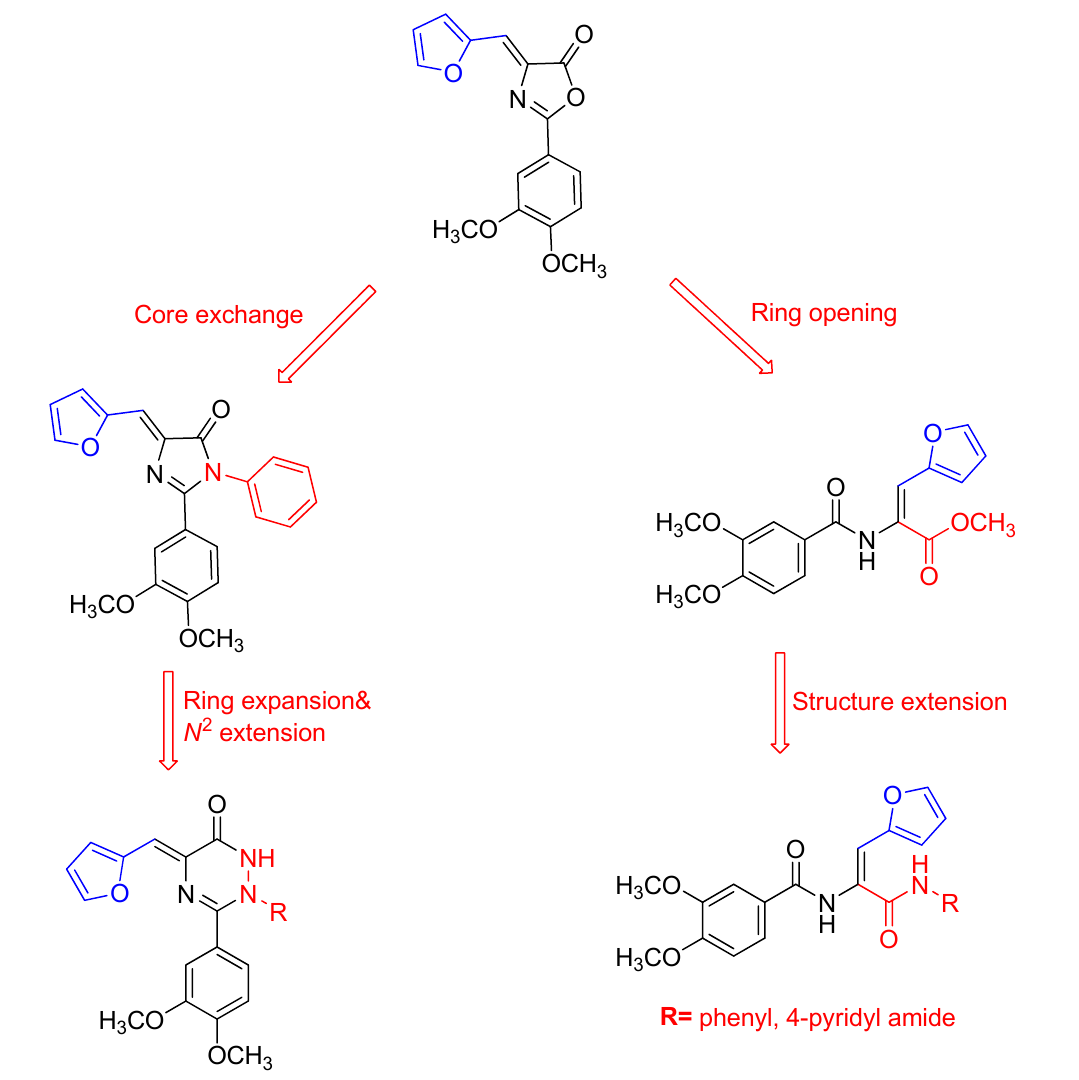
Figure 2. Design strategy of the prepared furan-based compounds.